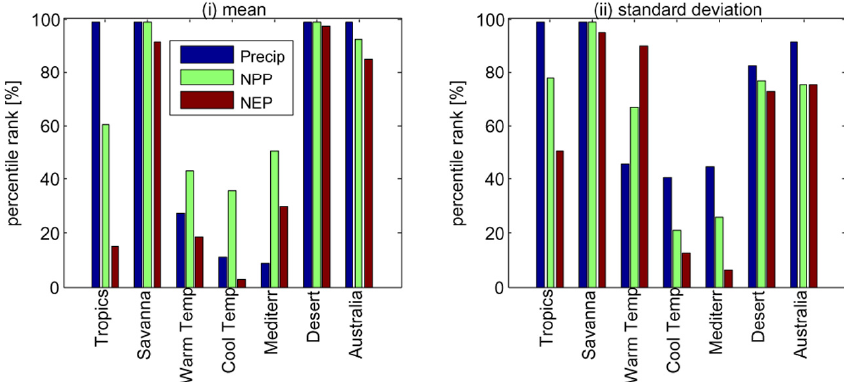
Fig. 7. Percentile ranks of the 1990–2011 (i) mean and (ii) standard deviation of precipitation, NPP and NEP, relative to all other 22-yr periods starting in successive years from